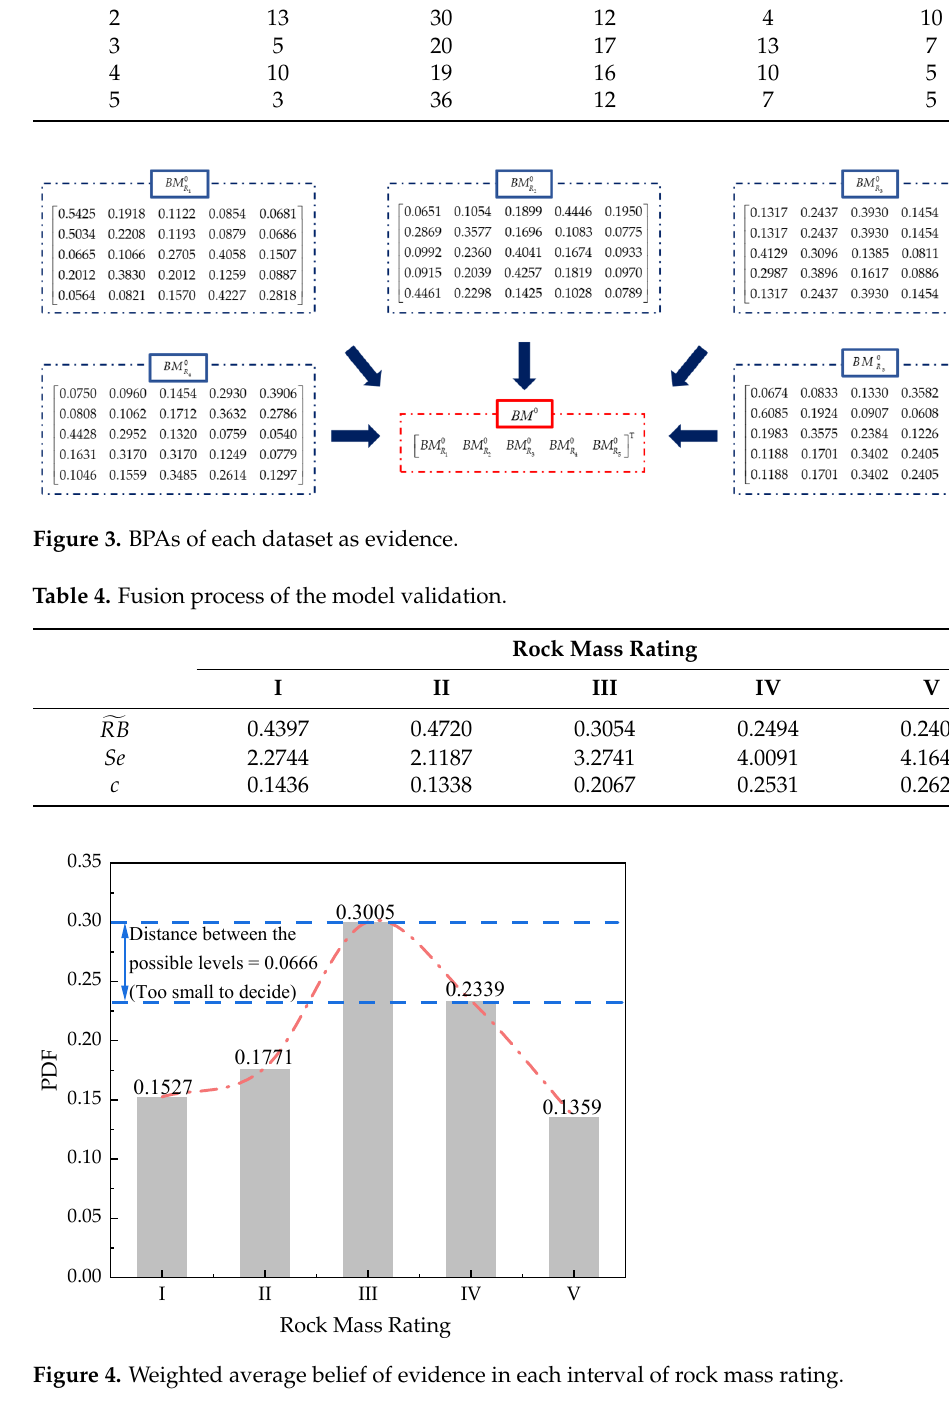
Figure 4. Weighted average belief of evidence in each interval of rock mass rating.